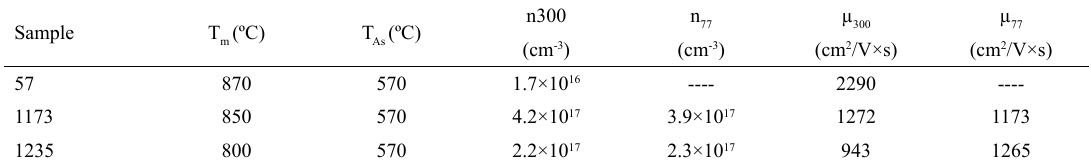
Ga As layers grown by solid-arsenic-based MOCVD. The table contains x 1-x